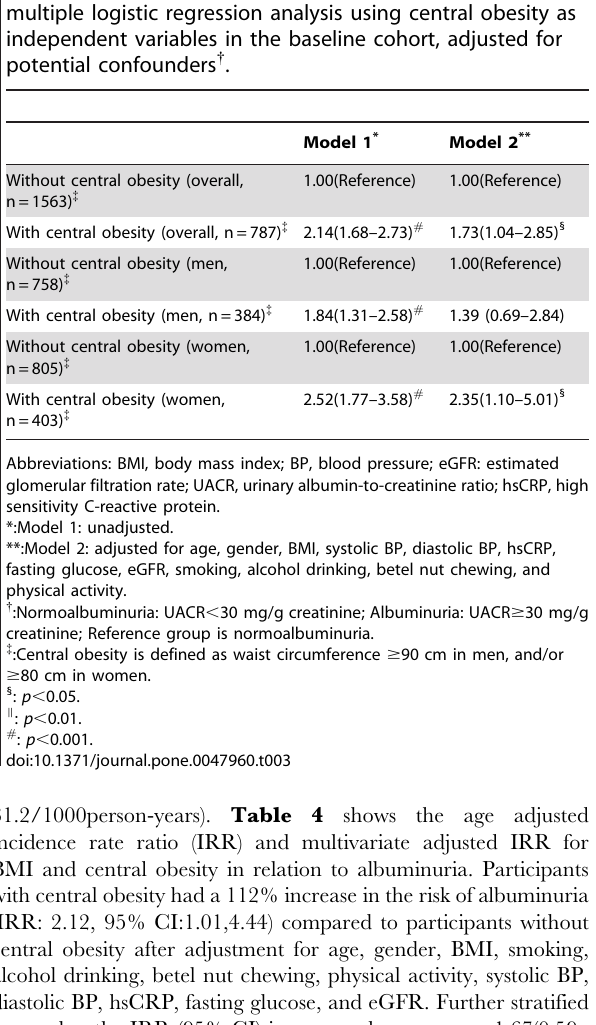
Table 4. Incidence rate ratio (95% confidence interval) of incident albuminuria according to body mass index and central obesity in the follow-up cohort {